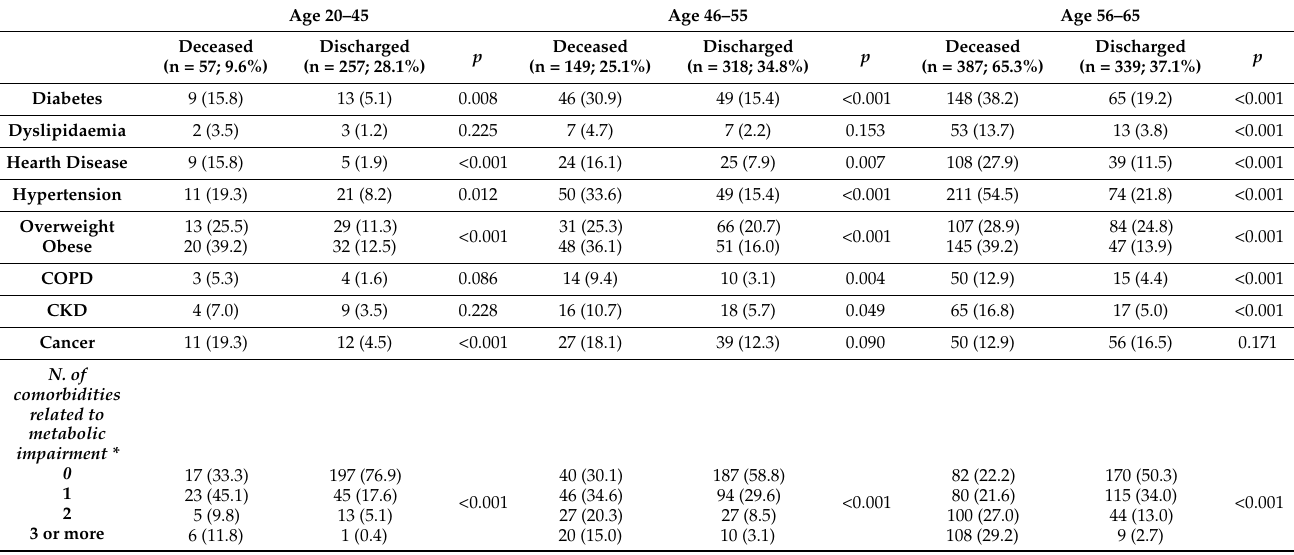
Table 2. Characteristics of study cohort stratified by mortality and age.